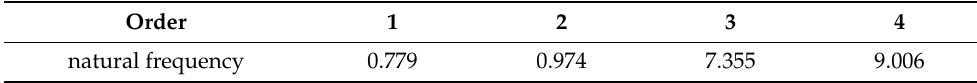
Table 2. Four natural frequencies of the half-car model